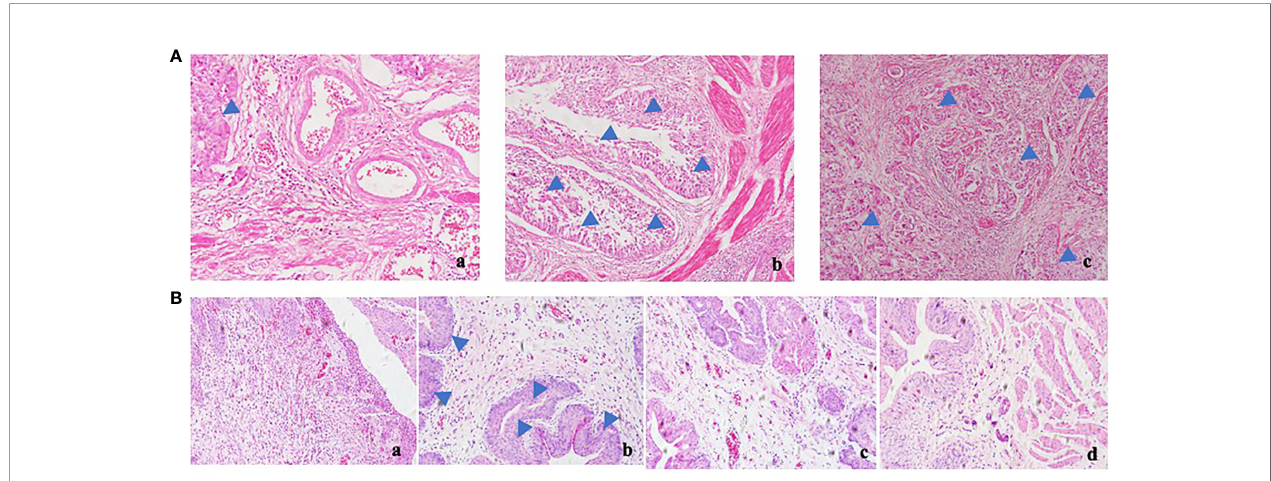
FIGURE 1 | Effect of polyporus on BBN bladder cancer rats. (A) HE staining of human bladder tumor specimens. a. paracancerous b, c. tumor tissue. (B) HE staining of BBN rats after intervention with polyporus extract and polysaccharide. a. Control group b. Model group c. PPS group d. WDP